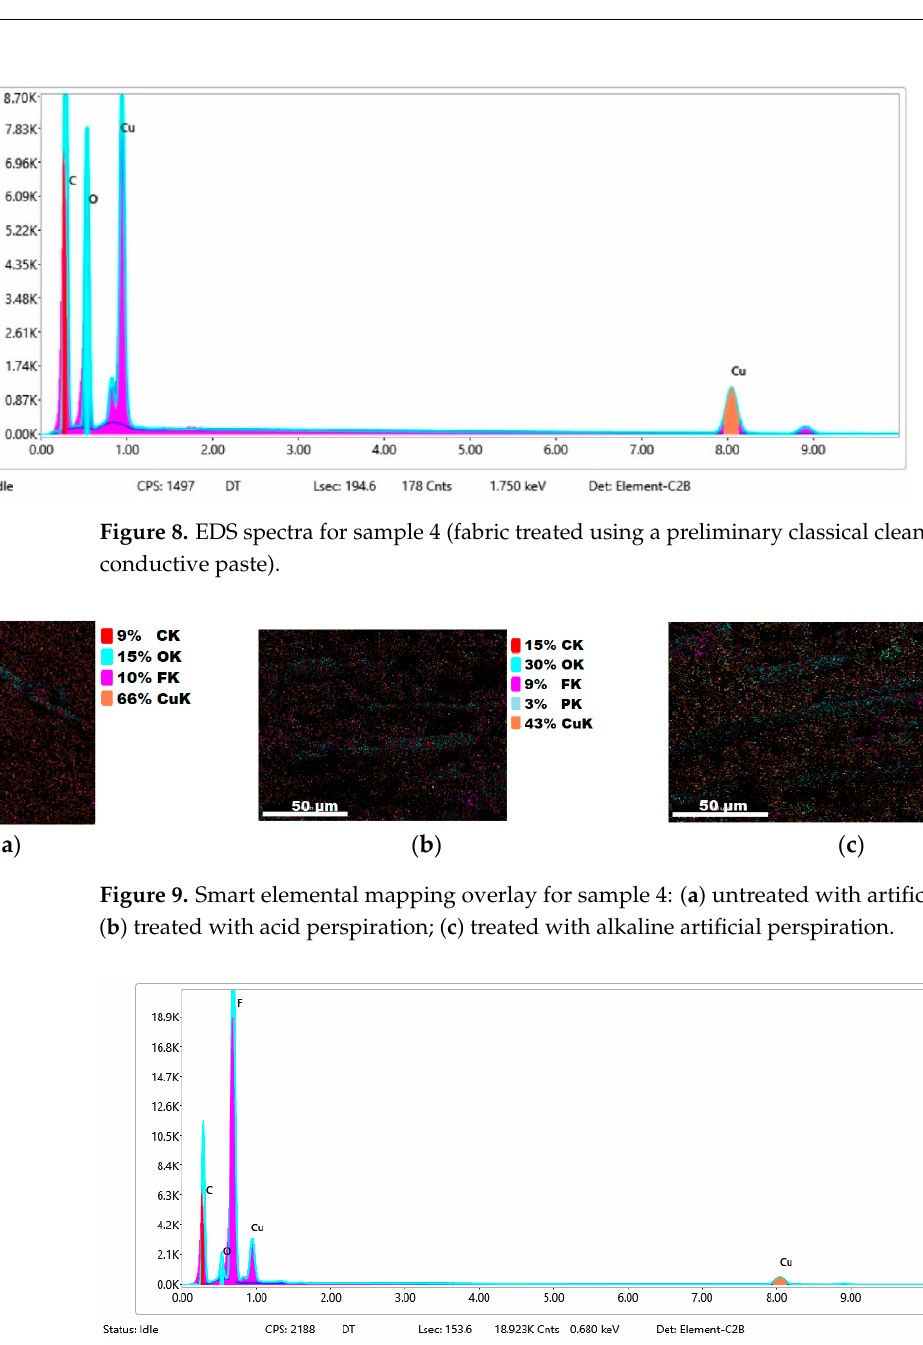
Figure 10. EDS spectra for sample 5 (fabric treated using preliminary classical cleaning method and conductive paste).